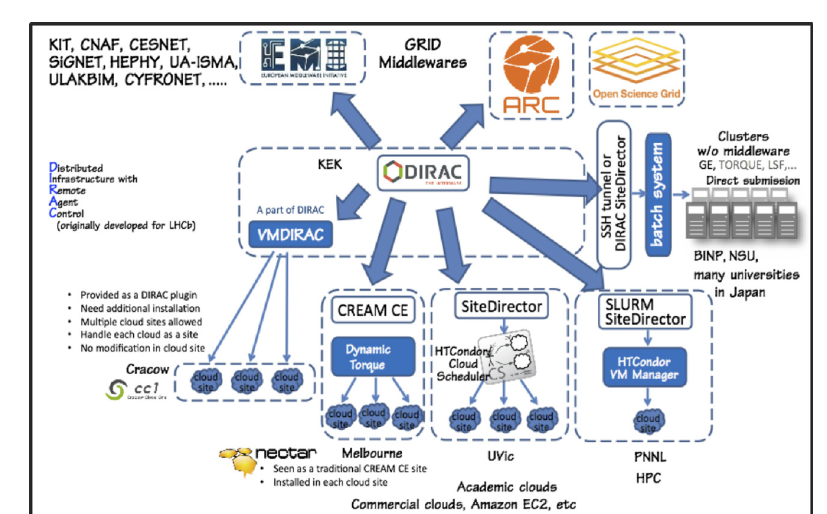
Figure 2: Schematic diagram of the Belle II computing interoperability using